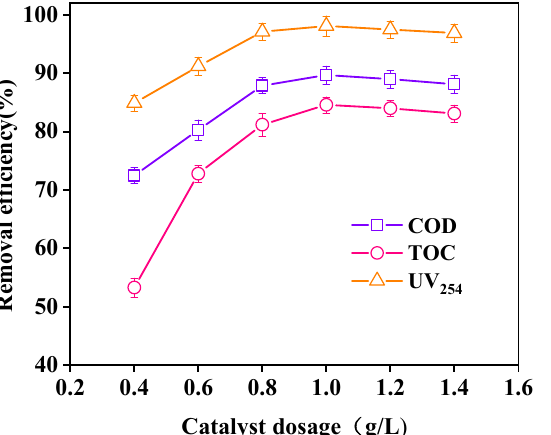
Figure 14. Effect of catalyst dosage on oxidation. (Reaction conditions: H 2 O 2 = 40 mM, 120 °C, 0.5 MPa, 60 min).